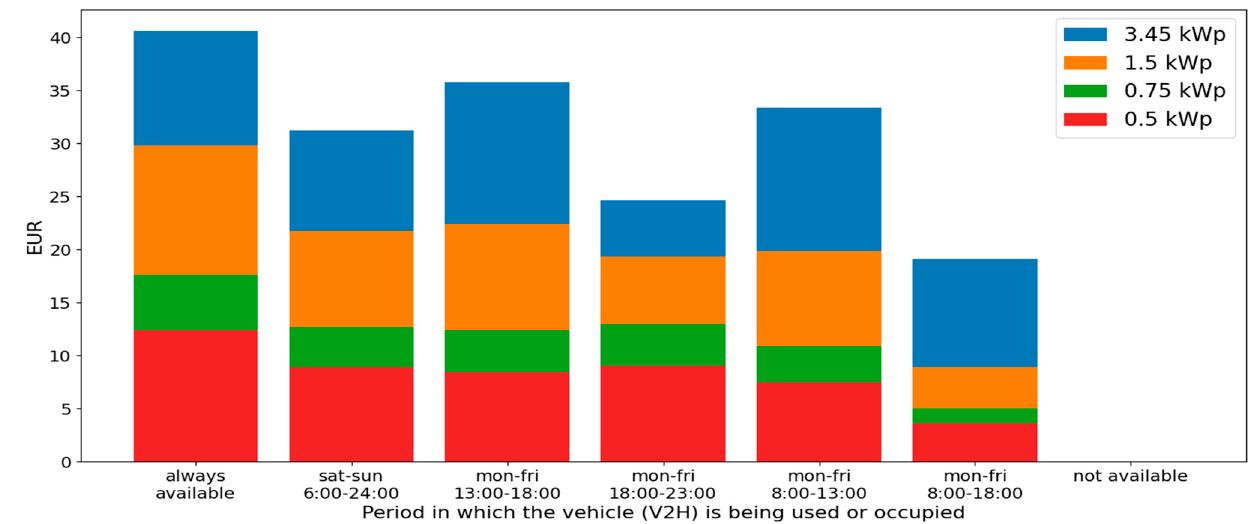
Figure 8. Average savings without injection (per month).